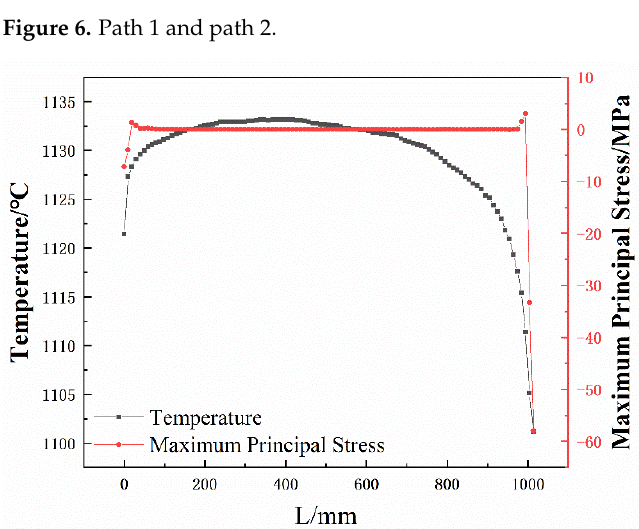
Figure 7. Temperature and maximum principal stress distribution on path 1.